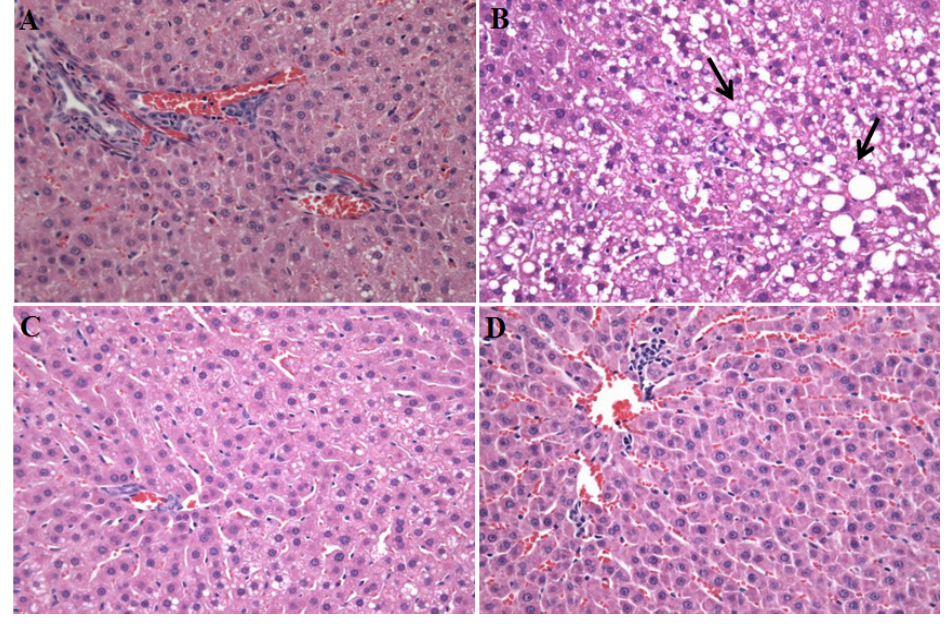
Figure 3. Histological images of liver tissues from HFD-induced obese rats hepatic steatosis displaying the hepatoprotective effects of A. capillaris extracts. There were no histological abnormalities observed in normal diets rats ( A ). Rats fed with a HFD for 13 weeks develop a high degree of steatosis, showing hepatocytes with severe cytoplasmic vacuoles and swelling ( B ). The treatments with 0.4% and 0.8% A. capillaris extracts resulted in the prevention of hepatic fatty deposition in hepatocytes ( C , D ). The tissues were surgically excised and subjected to histological study by staining with hematoxylin and eosin (H&E). All magnifications: 100×. The arrows indicate fatty